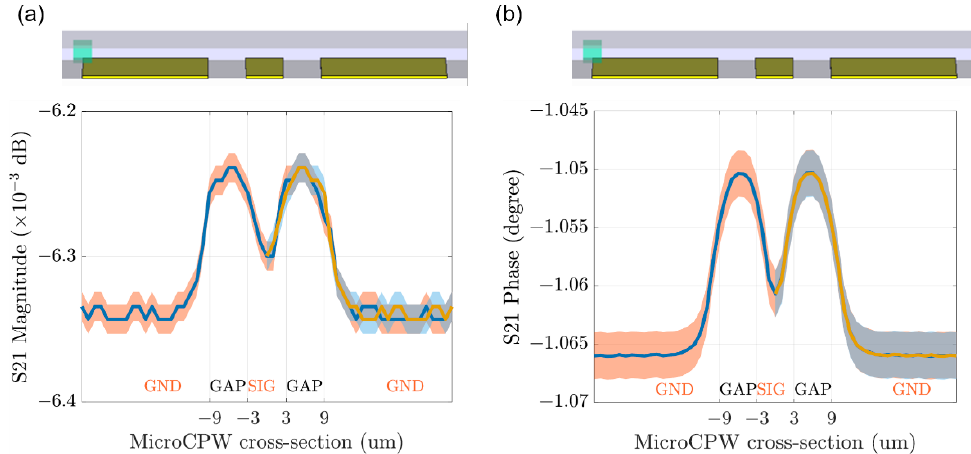
Figure 7. The CST simulation results in the particle at different positions relative to the cross-section of the sensing CPW structure to mimic the process of particle passing through the sensor. ( a ) the magnitude and ( b ) the phase of transmission signal S 21 . The blue solid line and the orange ribbon around it are simulation results and their error range respectively. While the yellow solid line and blue ribbon around it are respectively the mirrored simulation results and their error range of the left half to demonstrate their symmetry with the right half of the simulation results.